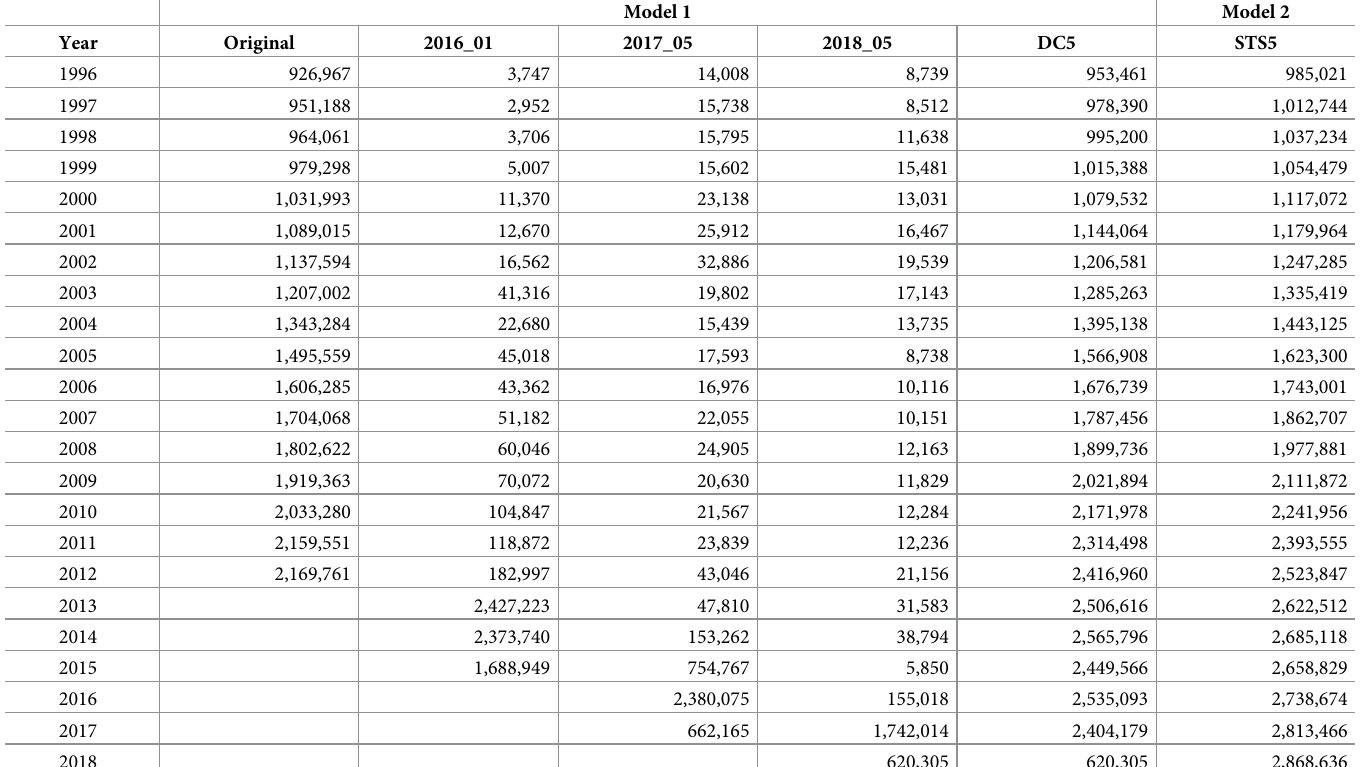
Table 1. Numbers of papers by year in each global model of science. For Model 1, numbers of papers added originally and at each update are also